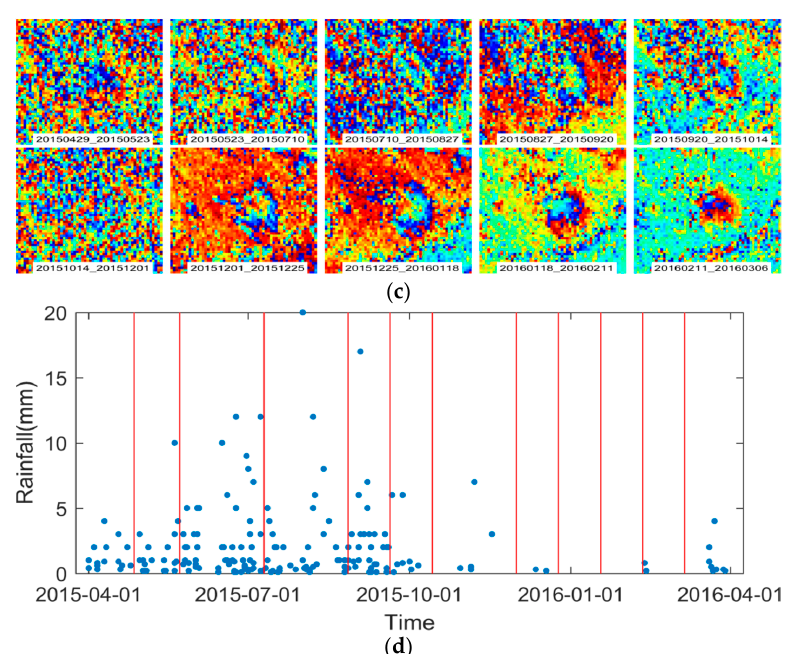
Figure 9. Differential interferograms in radar geometry generated with consecutive Sentinel-1A images illustrate land movement at area g ( a ); e ( b ); and k ( c ); the interferograms’ dates of master and slave images are given in the bottom; ( d ) shows the daily rainfall during the monitoring time span, the SAR acquisitions are marked with the red vertical lines.